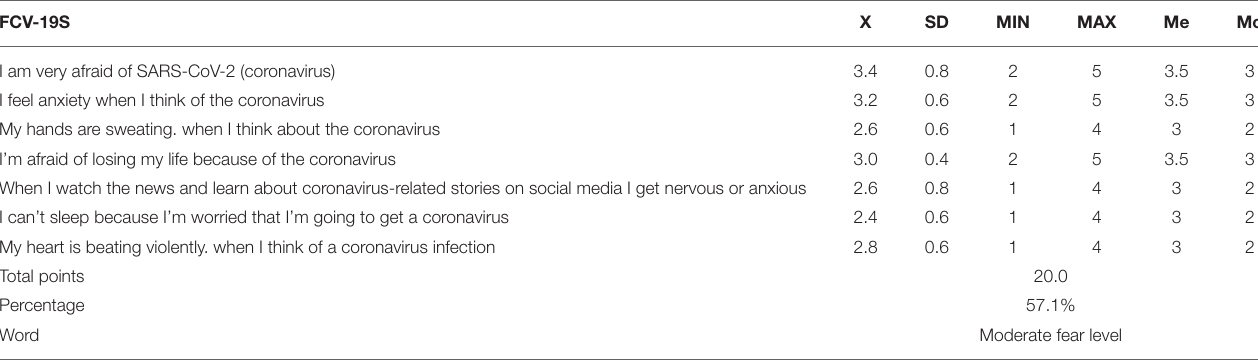
TABLE 3 | Level of fear of COVID-19 in the study group (according to FCV-19S)— N = 450. FCV-19S X